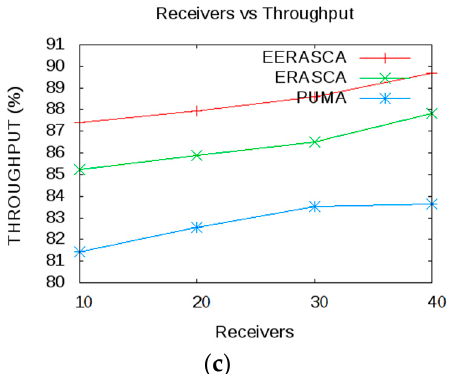
Figure 10. Comparison of Number of Receivers with PDF, Overhead and Throughput.